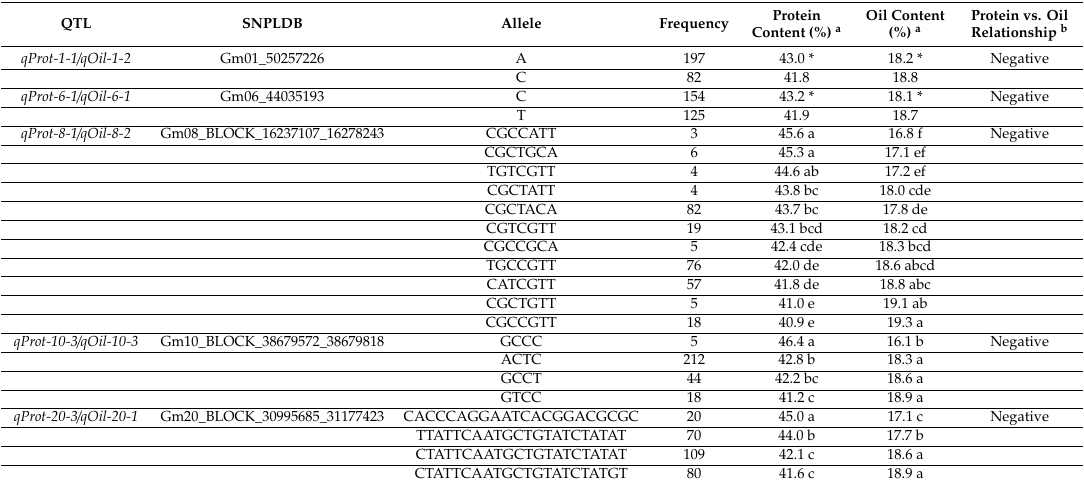
Table 4. T -test or multiple comparison among means of accessions grouped by the allele of QTLs associated with both seed protein and oil